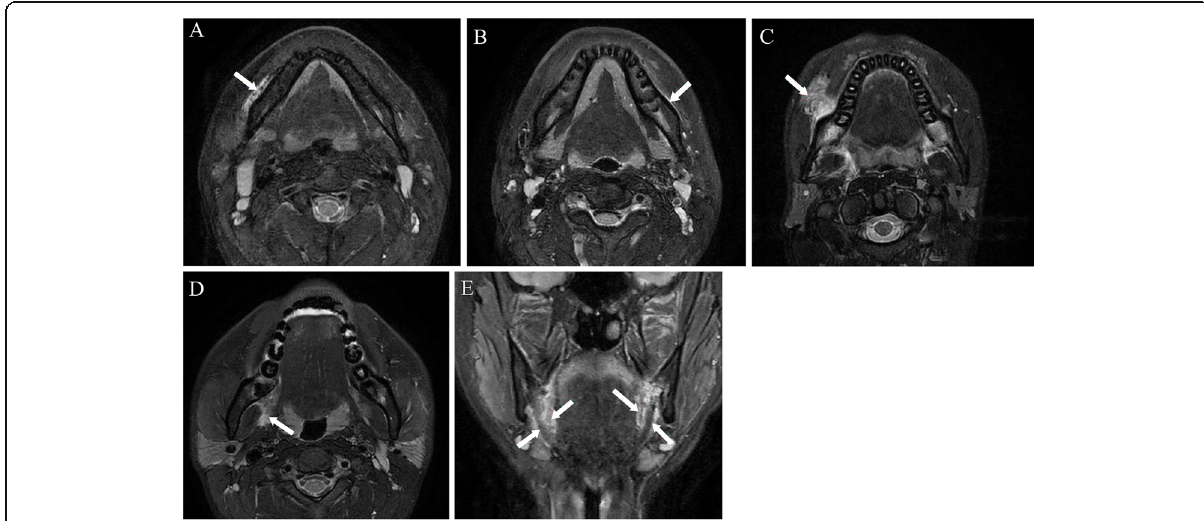
Fig. 2 Examples of edema in the postoperative spaces on magnetic resonance imaging. a Buccinator muscle (arrow). b Supra-periosteum space (edema space observed along the outer border of the mandible, arrow). c Buccal space (arrow). d Parapharyngeal space (arrow). e Lingual space (edema space on sublingual or submandibular space,